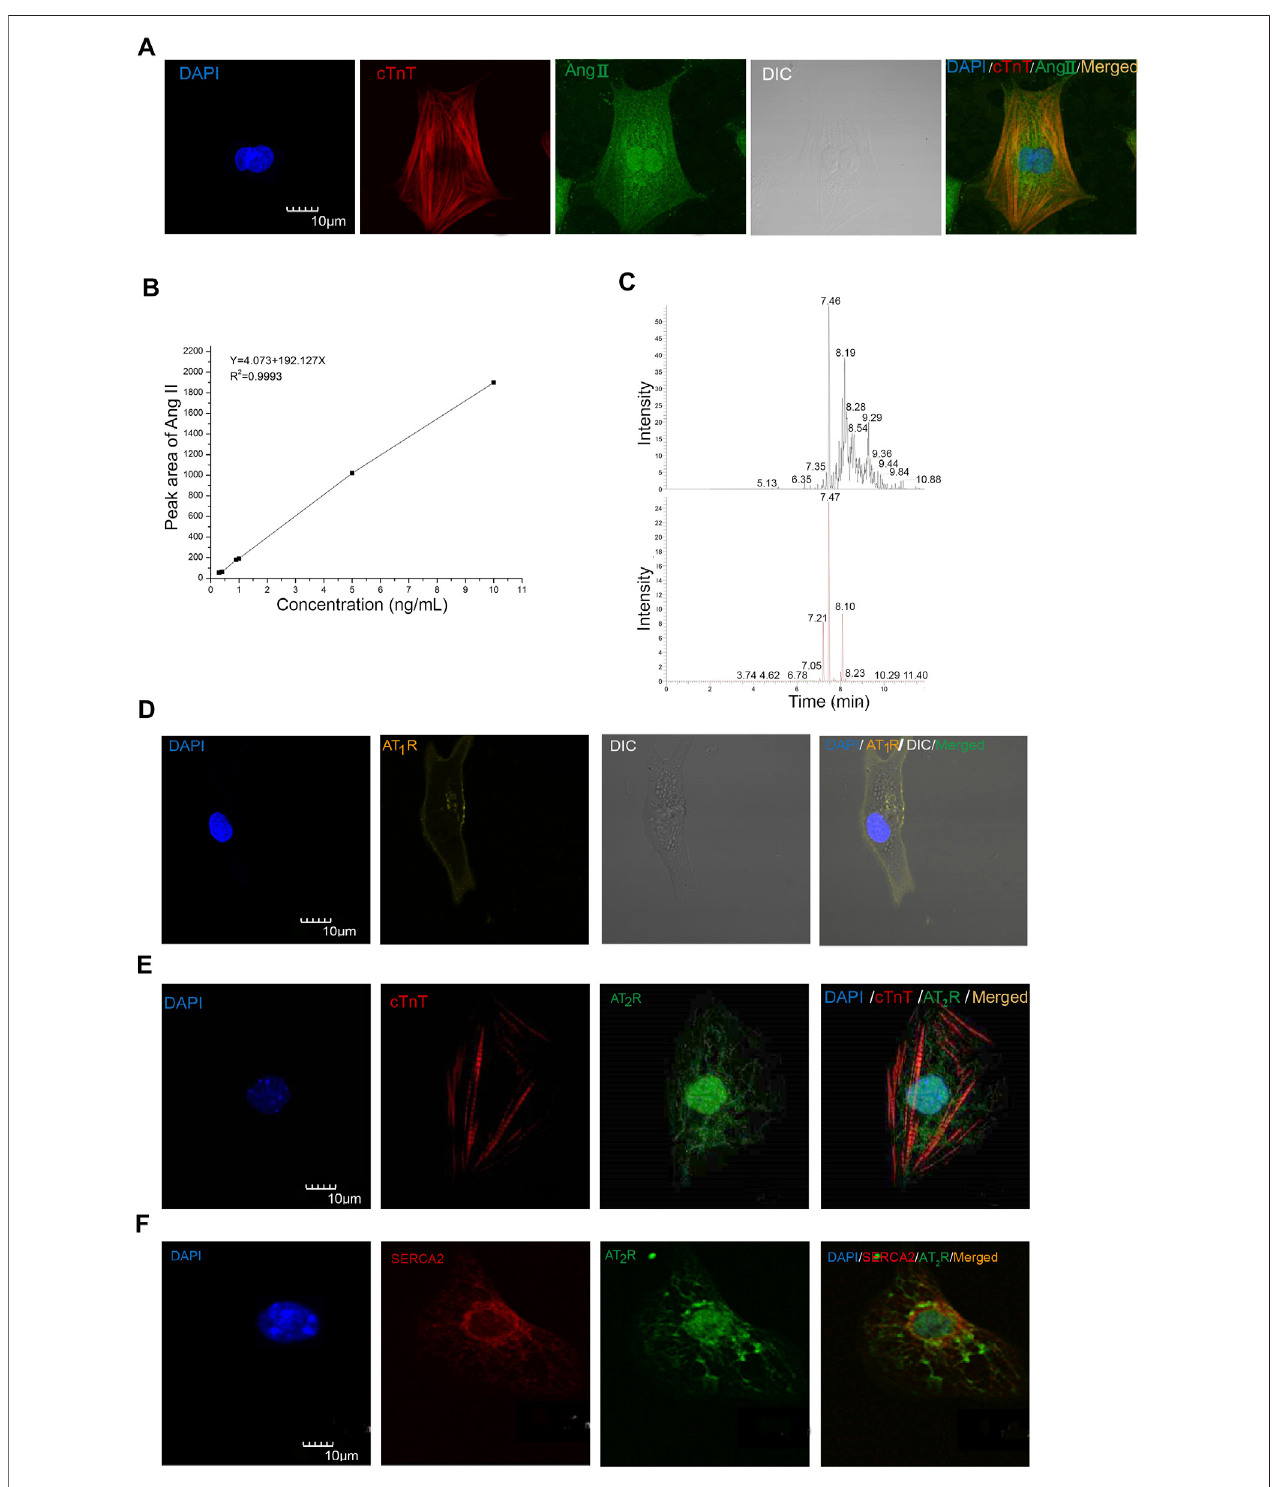
FIGURE 1 | Ang II, AT 1 R, and AT 2 R were detected in mESC-CMs and NRVMs. (A) Representative images showing the immunocytochemistry of iAng II in mESC-CMs. Cells were immunostained for cTnT (red), Ang II (green), and the nucleus with DAPI (blue). The results indicated that Ang II was present in mESC-CMs. (B) Linear calibrationcurve ofAng II. (C) AnalysisoftheNRVM samplesbyUHPLC-ESI-MS/MS. Theextracted ionchromatograms ofthetwokindsofMRM. Theupper one is the 523.8 ± 0.1 m/z → 263.1 ± 0.1 m/z; the lower one is the 523.8 ± 0.1 m/z → 784.4 ± 0.1 m/z. (D) mESC-CMs were transduced with the vector carrying AT 1 R-YFP and were stained with DAPI (blue). AT 1 R-YFP signals were detected on the plasma membrane. (E, F) mESC-CMs were stained with DAPI (blue), anti-AT 2 R (green), and (E) anti-cTnT (red) or (F) anti-SERCA2 (red). Merged images revealed extensive co-localization of AT 2 R with the nucleus and the SERCA2, suggesting that AT 2 R was located predominately on the nucleus and the SR. Scale bars represent 10 μ m.